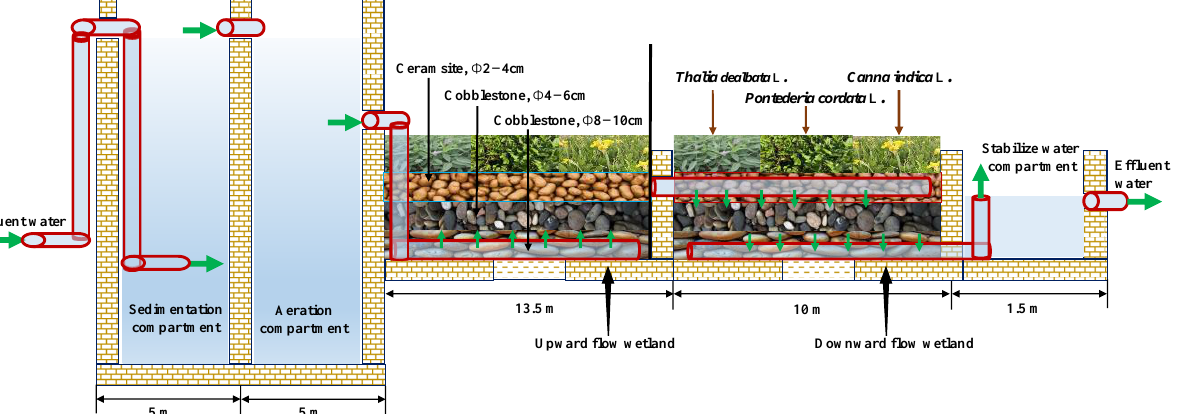
Figure 1. Schematic representation of the constructed wetland. It consists of a sedimentation compartment (5 m × 7.5 m), continuously aerated compartment (5 m × 7.5 m), upward flow wetland (13.5 m × 15 m), and downward flow wetland (10 m × 15 m) and stabilize water compartment (1.5 m × 15 m). The green arrow indicates the direction of the water flow. The bottom layer of wetland was filled with 20 cm of cobblestone (diameter 8 – 10 cm), the middle layer was filled with 20 cm of cobblestone (diameter 4 – 6 cm), and the top was laid a layer of 30 cm of biological ceramsite (diameter 2 – 4 cm). The wetland was planted with Thalia dealbata L., Pontederia cordata L. and Canna indica L.